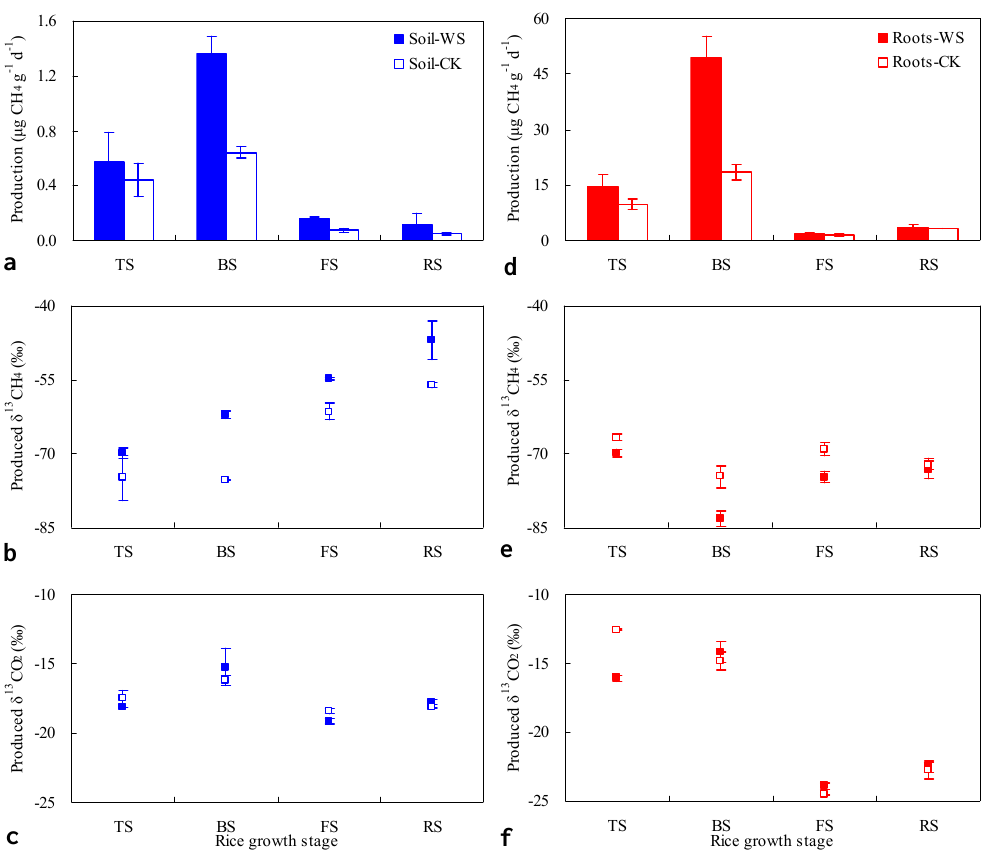
Fig. 2. Potential CH 4 production rates in anaerobically incubated paddy soil (a) and rice roots (d) , and corresponding δ 13 C-values of CH 4 ( (b) and (e) ) and CO 2 ( (c) and (f) ) at the four rice growth stages. TS: tillering stage, BS: booting stage, FS: grain-filling stage, RS: ripening stage. WS: straw incorporation, CK: without straw incorporation. Mean ± SD, n = 3. pleted in 13 C, on average, by ∼ 16 ‰ (Treatment WS) and ∼ 4 ‰ (Treatment CK) relative to that produced in paddy soil (Fig. 2b, e) during the four rice growth stages for